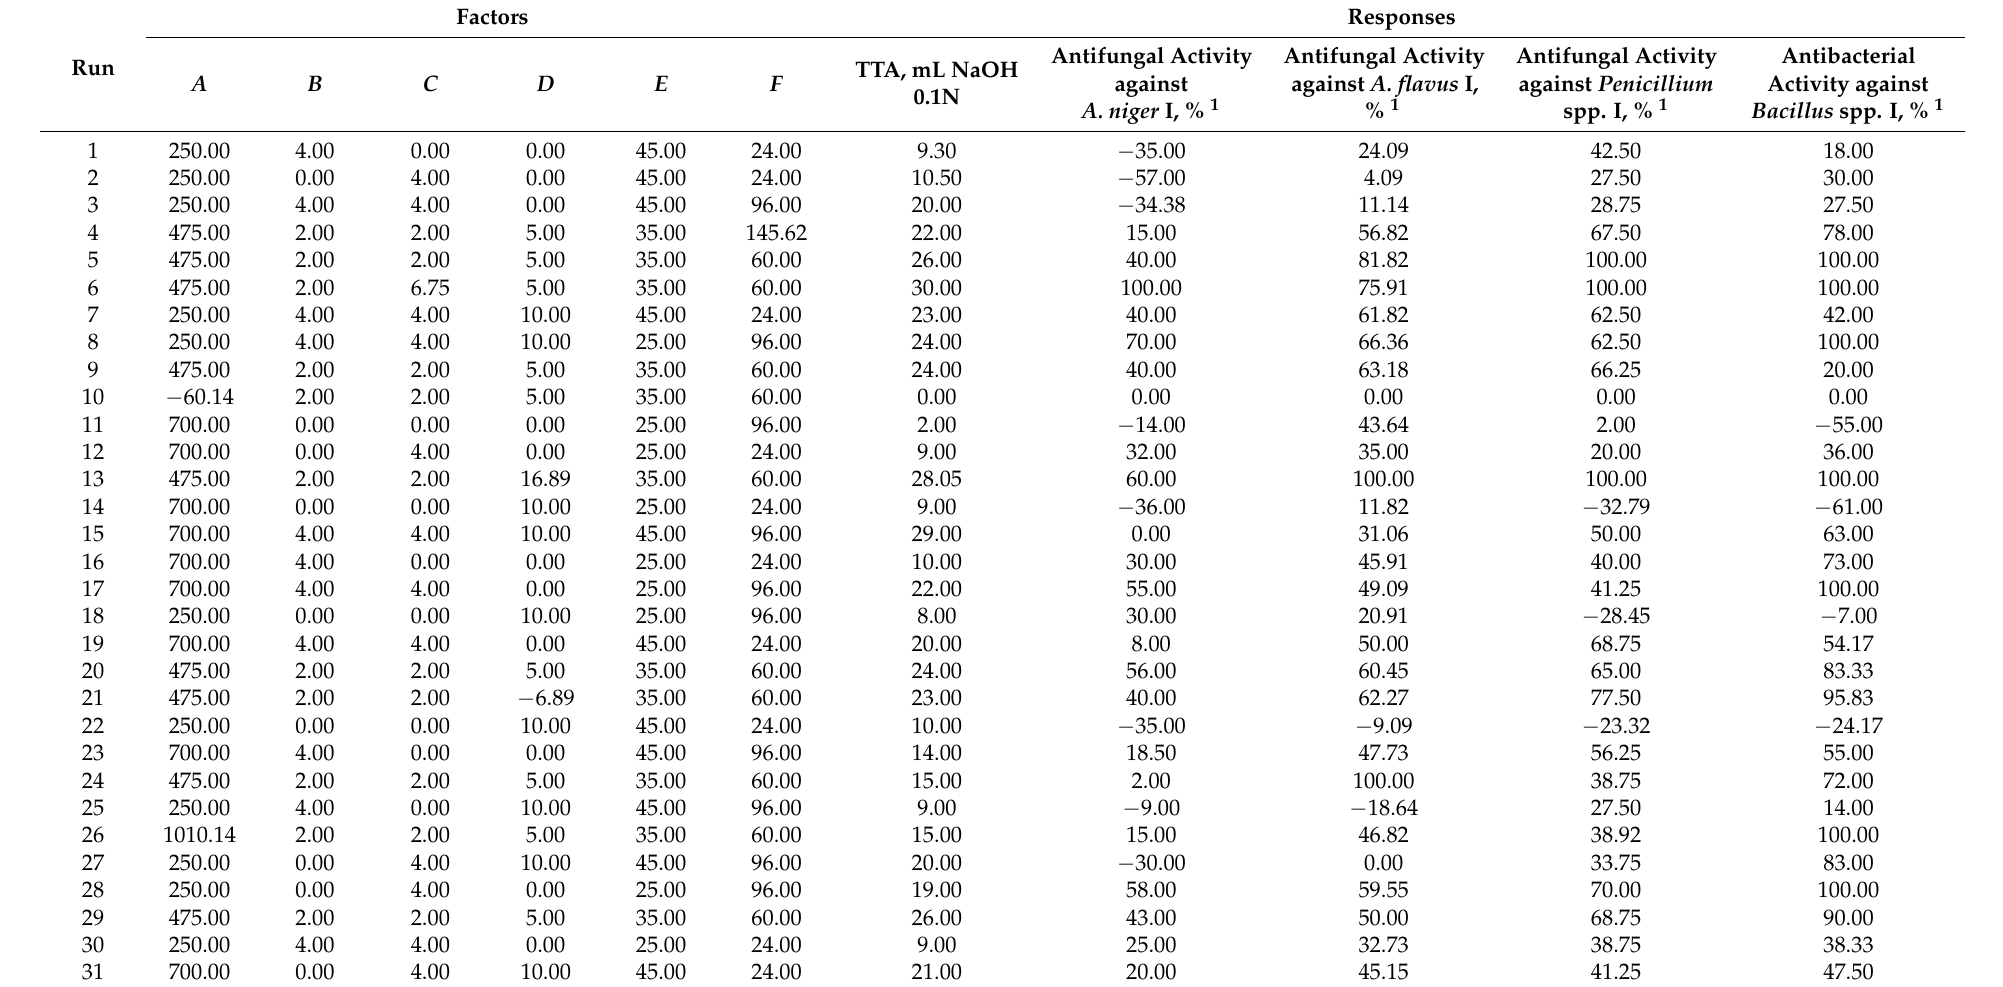
Table 4. Experimental results of the total titratable acidity (TTA) and inhibition ratio ( I , %, defined by the Equation (2)) obtained by Response Surface Methodology (RSM). The meaning of the selected factors A to F is given in Table